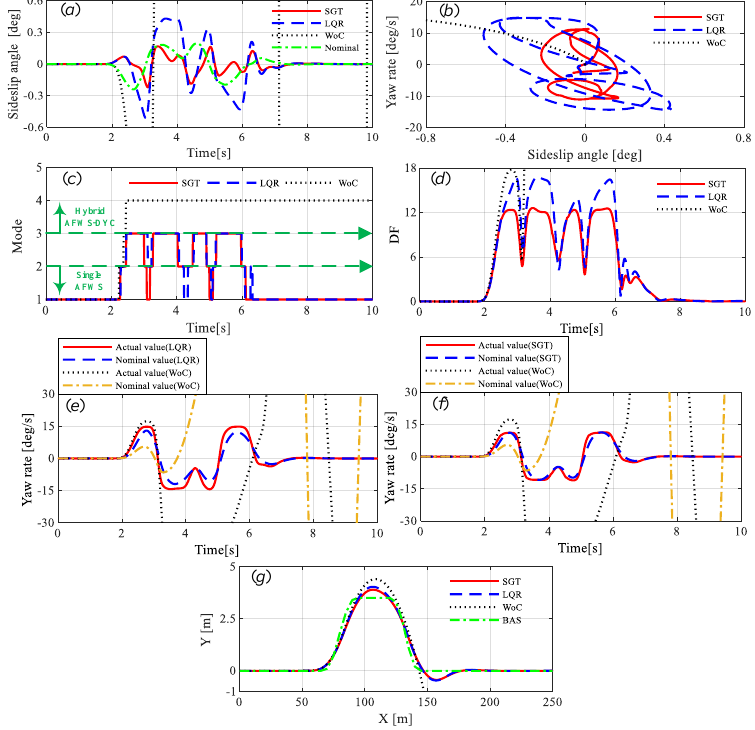
Figure 9. Dynamic responses of DLC test at 100 km / h. ( a ) Sideslip angle; ( b ) β - ω phase portraits; ( c ) working mode; ( d ) dangerous factor (DF); ( e ) yaw rate of LQR; ( f ) yaw rate of SGT; ( g ) Y position.